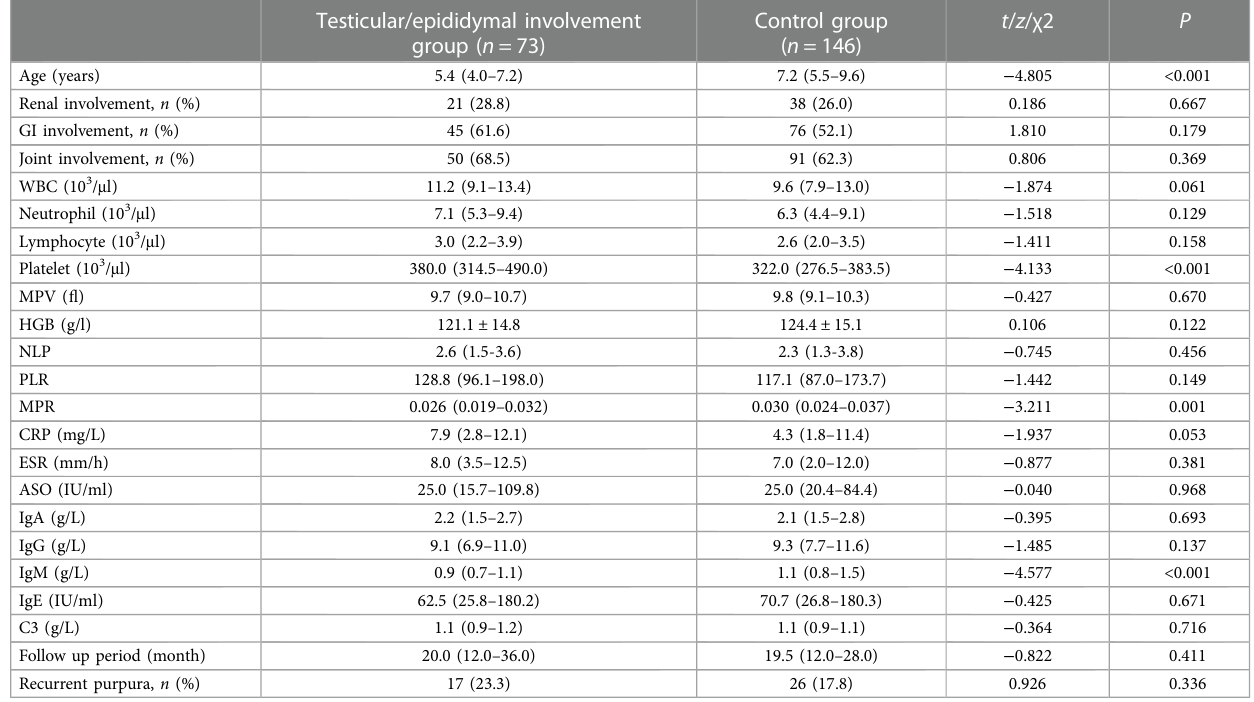
TABLE 1 Comparison of clinical features and laboratory and follow-up data of the two groups.